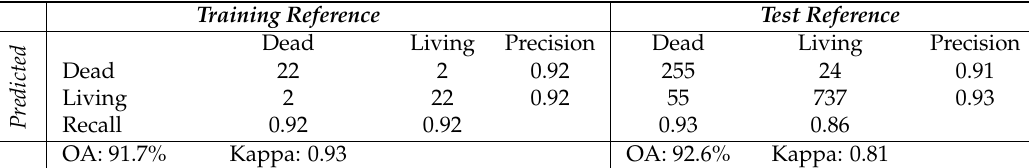
Table 15. Classification results of dead trees. Labelled data are from areas A 1, A 2, and A 3. Šumava National Park: 163 dead trees with crowns, 356 living trees for training. 109 dead trees, 142 living trees for testing. Tree segments are classified as dead trees if the threshold for class probability p dead >